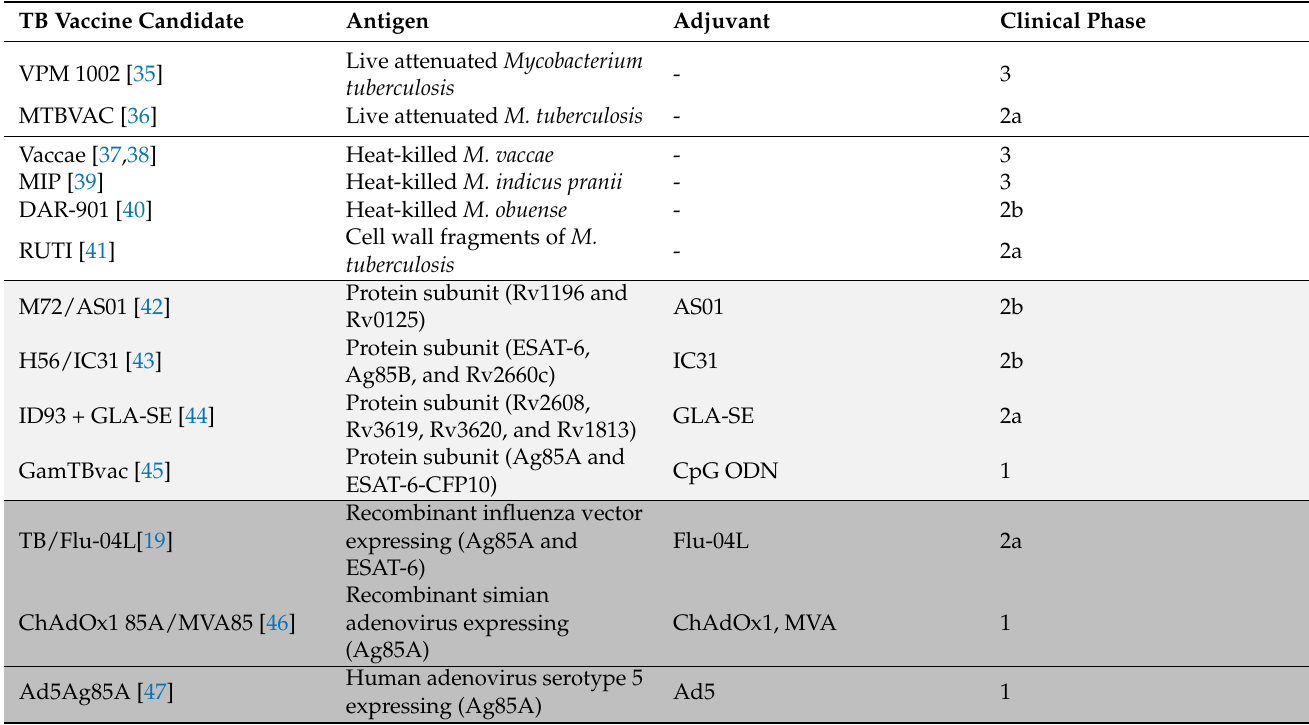
Table 1. TB Vaccine candidates in clinical